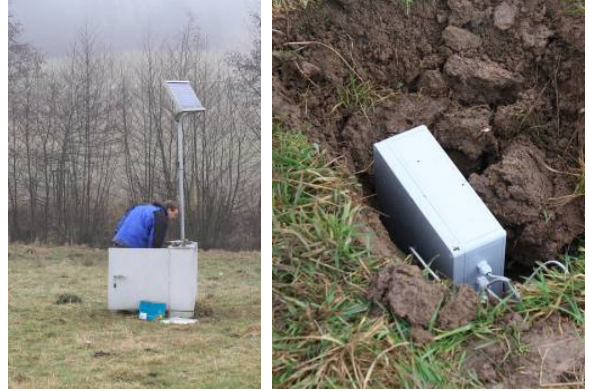
Figure 4. Base station and a radio module.